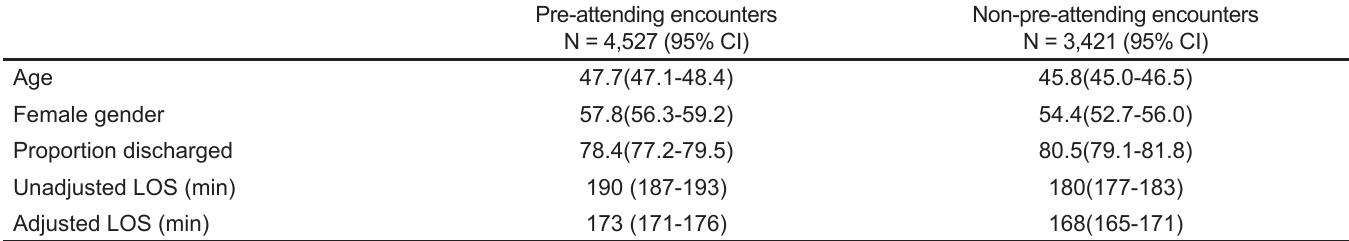
Table. Patient demographics and mean length of stay for control (non-pre-attending encounters) and experimental (pre-attending encounters)